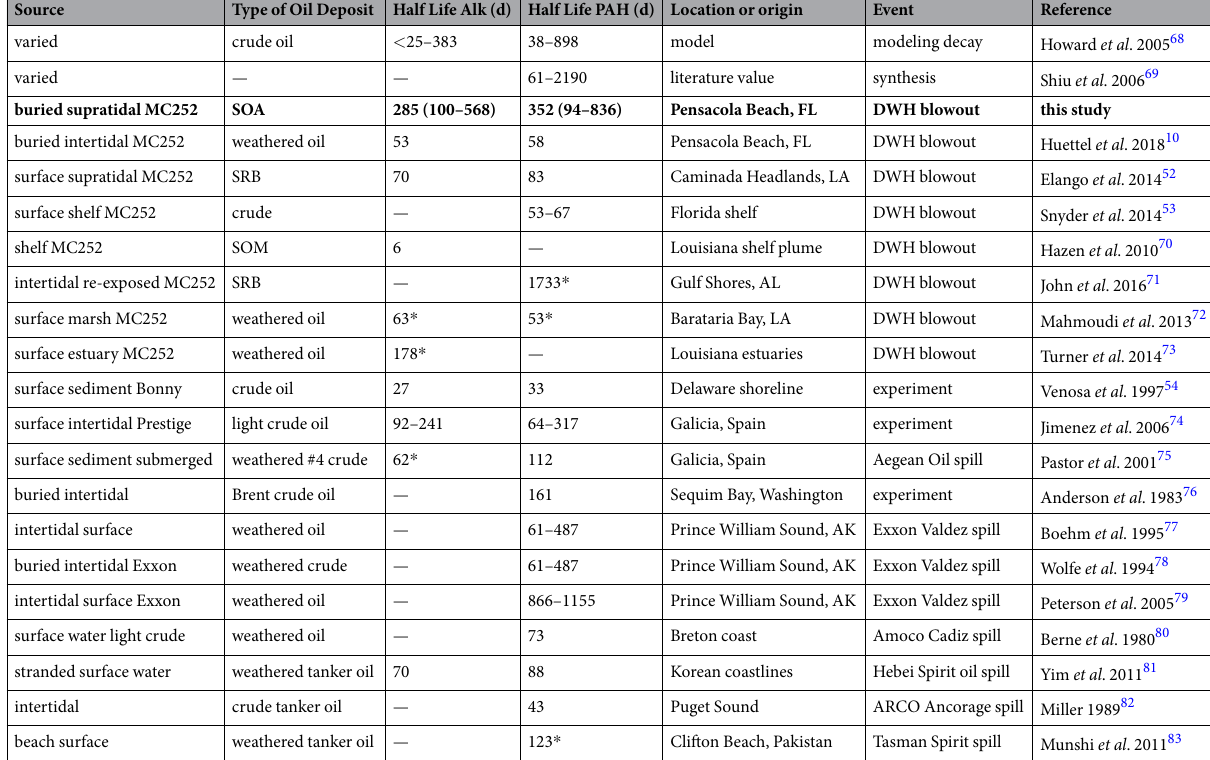
Table 1. Comparison of half-lives of petroleum hydrocarbons reported for coastal marine environments (half-life = LN(2)/decay rate constant). * Values calculated from publication data (not reported by actual